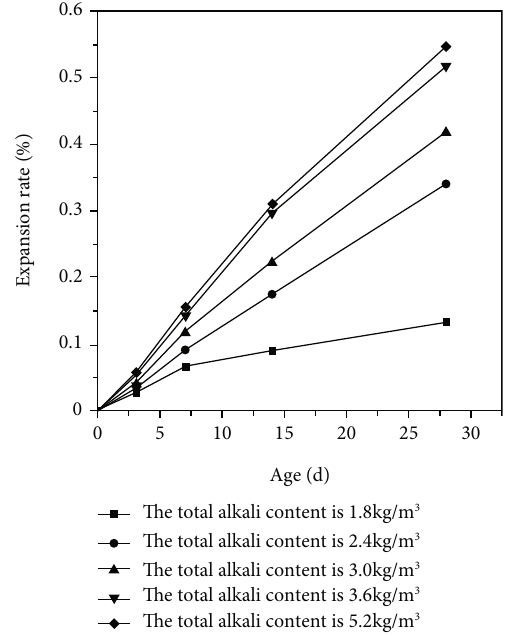
Figure 18: Graph of the e ff ects of powdered coal ash mix on alkali- aggregate reaction.